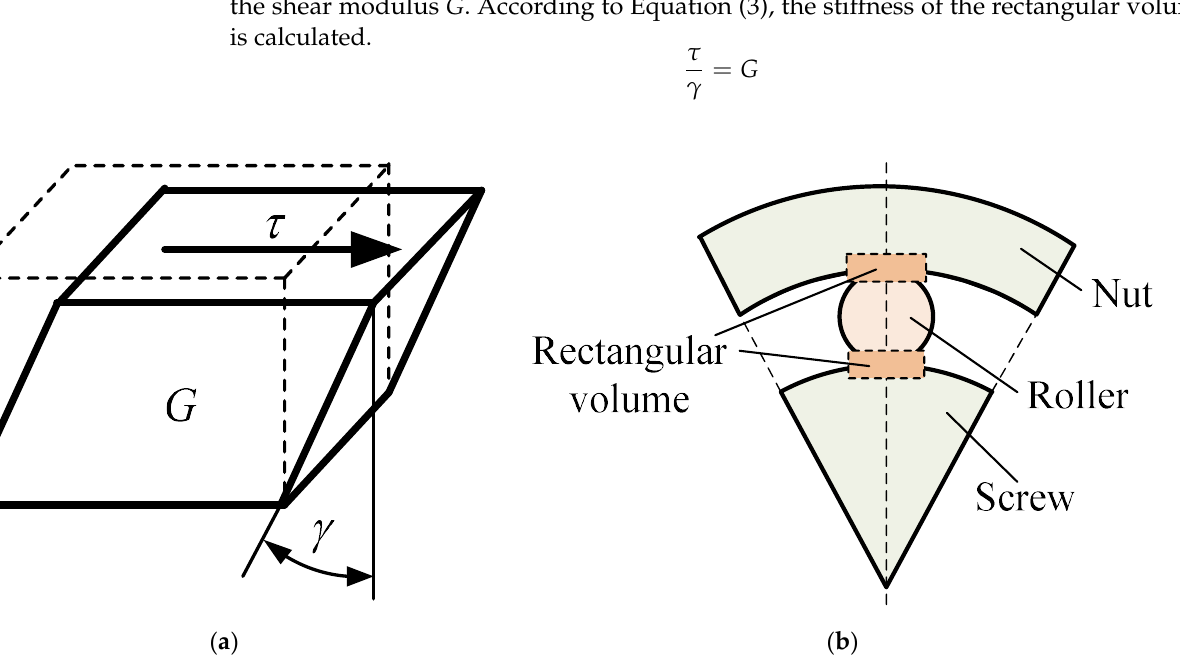
Figure 7. ( a ) Load and displacement of rectangular volume; ( b ) location and dimensions of rectangular volumes in Ref. [39].